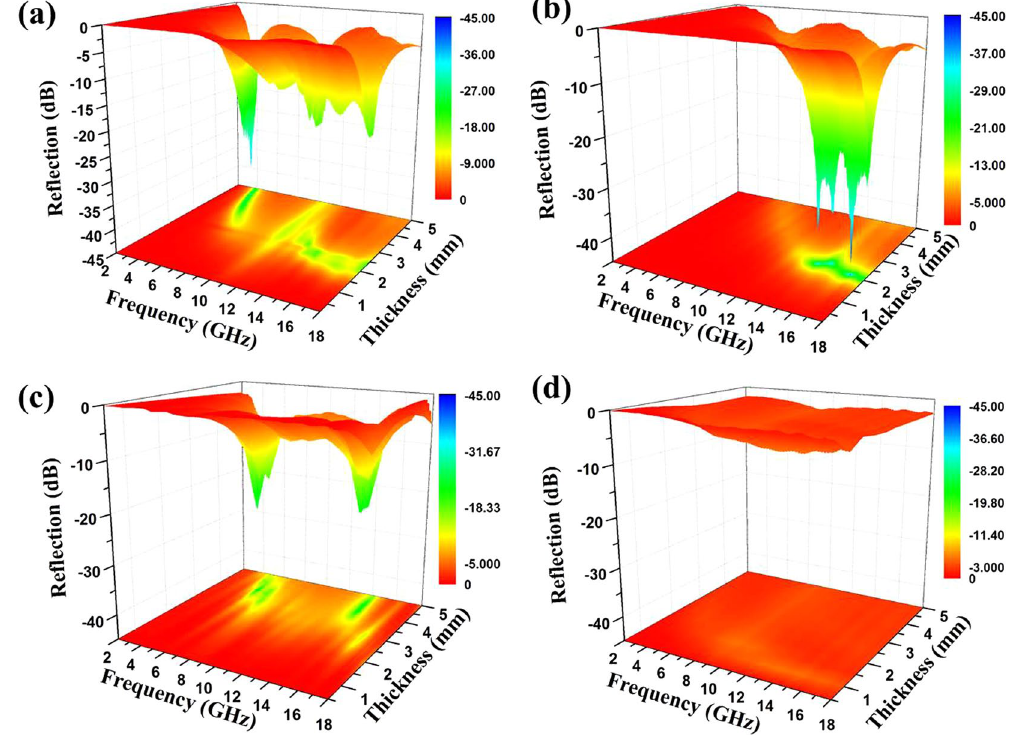
Figure 9. Three-dimensional representation of RL curves for Cu@Ni NWs/GO (1:0.5) ( a ), Cu@Ni NWs/GO (1:1) ( b ), Cu@Ni NWs/GO (1:2) ( c ), and Cu@Ni NWs/RGO (1:1) ( d ).